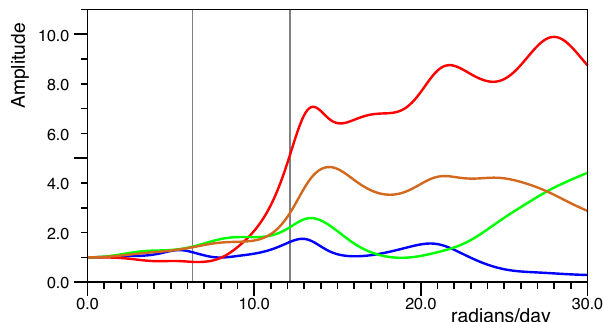
Fig. 3. The response function amplitude as a function of angular velocity for Portishead (red), St. Malo (brown), Workington (blue) and Le Havre (green). Vertical lines indicate the angular velocities of the K1 and M2 tides.